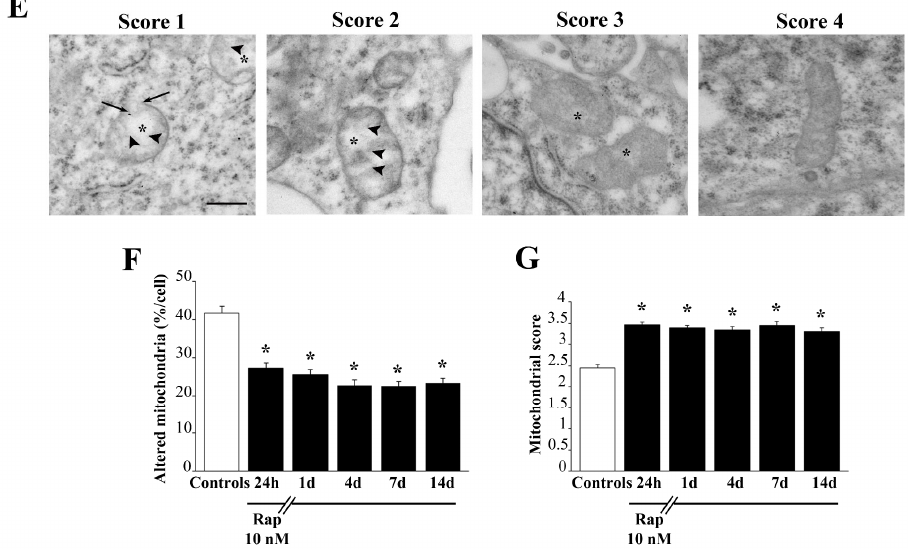
Figure 6. Rapamycin persistently increases the number of mitochondria and produces a long-lasting rescue of altered mitochondria. ( A ) Representative pictures show total mitochondria stained with MTR-G from controls and following rapamycin treatment (10 nM) for 24 h and after rapamycin withdrawal (up to 14 d), Arrows indicate intensely fluorescent signals. ( B ) Graph reports the two-fold steady increase in mitochondrial MTR-G fluorescence induced by rapamycin, which persists unmodified for 14 days. Values are given as the mean ± S.E.M from N = 100 cells per group. ( C ) Representative pictures at TEM show the increase in mitochondria (M) counted directly as specific organelles. ( D ) Graph reports the count of mitochondria per cell at TEM which overlaps the two-fold increase measured at MTR-G fluorescence, which similarly persists at 14 days. Values are given as the mean ± SEM from N = 50 cells per group. ( E ) Representative pictures depicting mitochondrial morphology evaluated based on the modified scale from Flameng et al. 1980 [23]. A score of 1 indicates that mitochondria possess broken crests (arrowheads) with ruptured mitochondrial membranes (arrows), and a spread matrix dilution (asterisk); a score of 2 indicates a mitochondrion that possess broken crests with spots of diluted matrix but membranes intact; a score of 3 indicates that mitochondria possess only spots of diluted matrix but intact crists and intact inner/outer mem- branes; the score of 4 indicates an intact mitochondrion. Graph ( F ) reports the percentage of altered mitochondria (including all kinds of alterations). Graph ( G ) reports the average of mitochondrial score. Values are given as ( F ) the percentage ± SEM from N = 50 cells per group or ( G ) the mean mitochondrial morphological score ± SEM calculated by averaging mitochondrial scores from at least 150 mitochondria from each experimental group. * p < 0.05 compared with controls. Scale bars: ( A ) = 18 µ m; ( C ) = 260 nm; ( E ) = 230